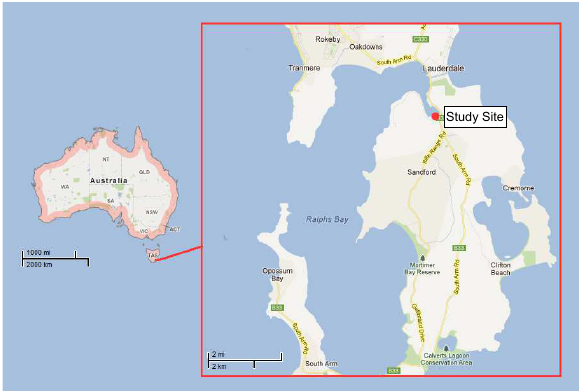
Figure 2: Location of Salt Marsh Study Site at Ralphs Bay, Tas- mania, Australia (Map Source: GoogleEarth) An area of Ralphs Bay salt marsh was selected to serve as a test site. UAV salt marsh missions were conducted at heights of 50 m and 100 m at an exposure of 2,000 and 4,000. Multispectral imagery was generated by the mini-MCA with a bandpass